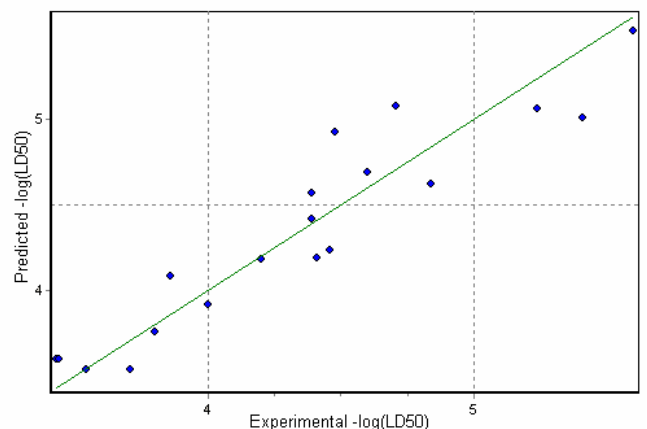
Figure 6. Correlation of Predicted versus Experimental toxicities for model D